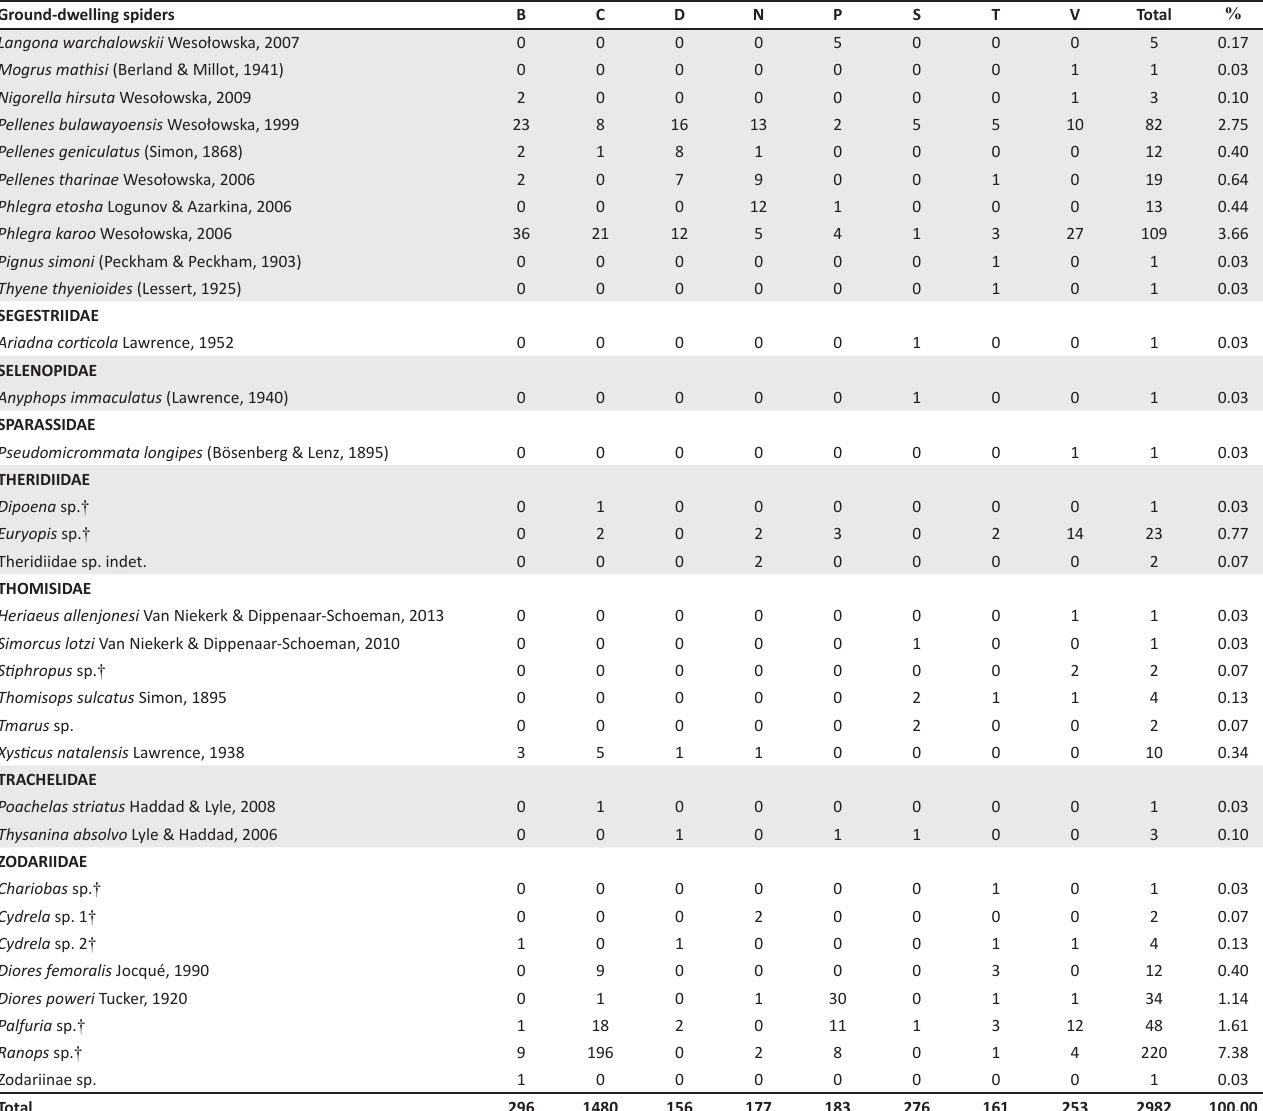
TABLE 1-A1 (Continues...): Ground-dwelling spiders collected by pitfall trapping from eight habitats in the Amanzi Private Game Reserve. Ground-dwelling